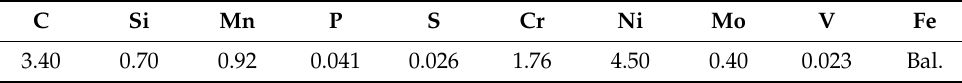
Table 1. Chemical composition of indefinite chill cast iron (wt